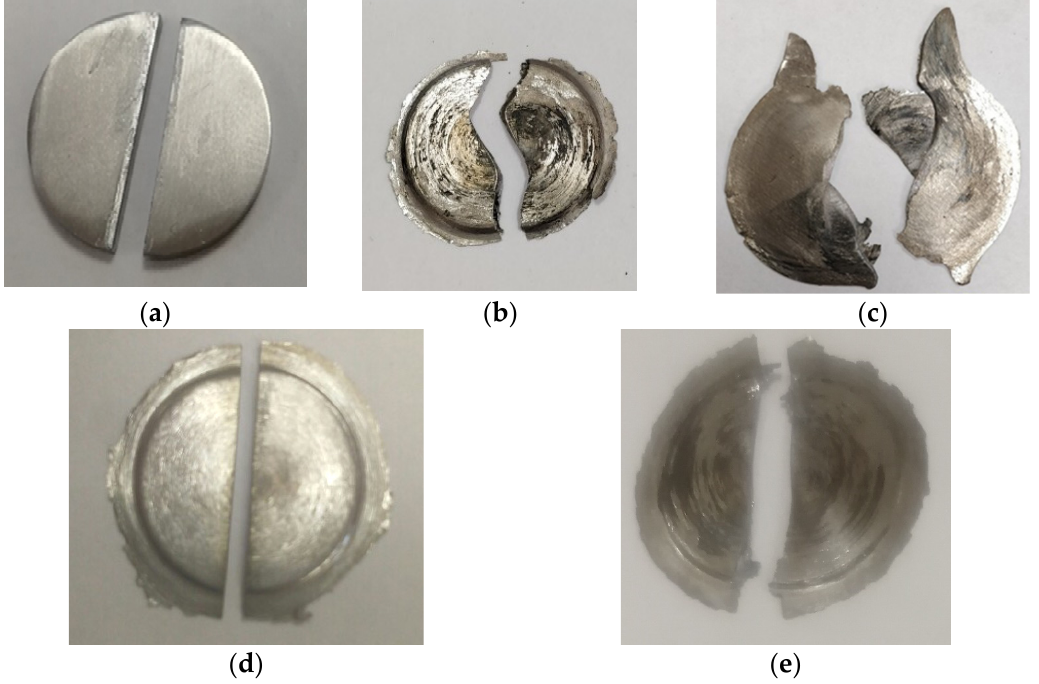
Figure 2. Two Ti disk halves d = 20 mm prepared for joint HPT ( a ), ( b ) Ti halves after joint HPT n = 1 on grooved anvils, ( c ) Ti halves after joint HPT n = ¼ on flat anvils; ( d ) Ti disk after HPT n = 5 cut for joint HPT; ( e ) the same halves after subsequent joint HPT n = 1 ( n = 5 + 1).